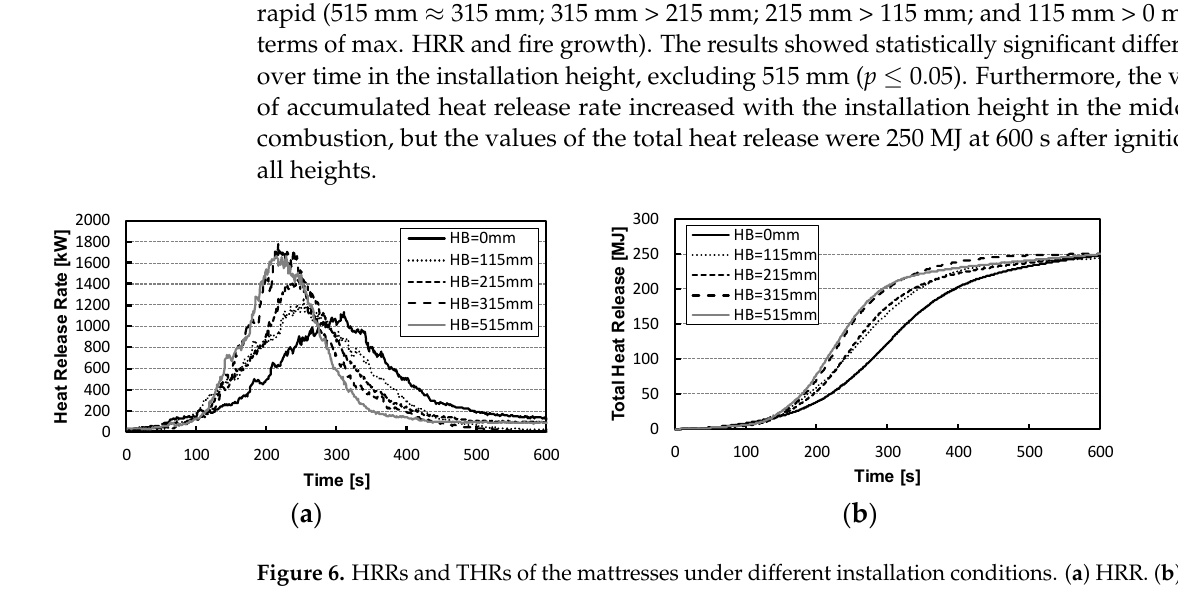
Figure 6. HRRs and THRs of the mattresses under different installation conditions. ( a ) HRR. ( b ) THR.